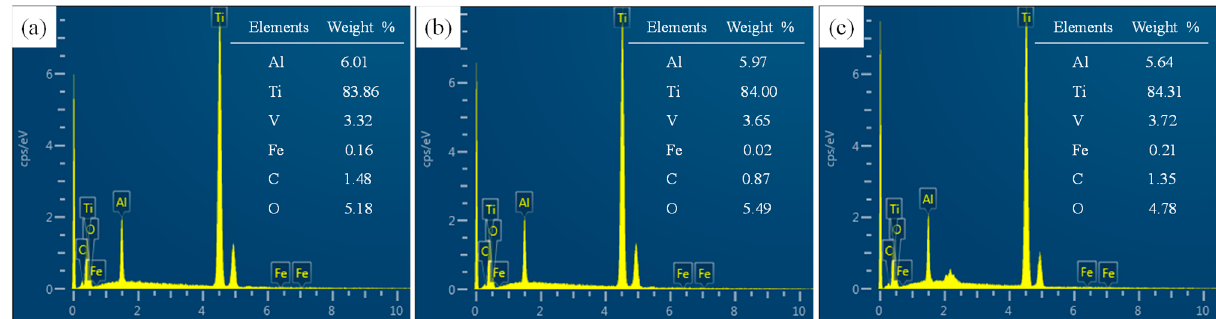
Figure 16. EDX results of typical areas of Ti6Al4V alloy surface before and after polishing: ( a ) EDX results before polishing; ( b ) EDX results of surface after polishing using SR bonnet; ( c ) EDX results of surface after polishing using PR bonnet.